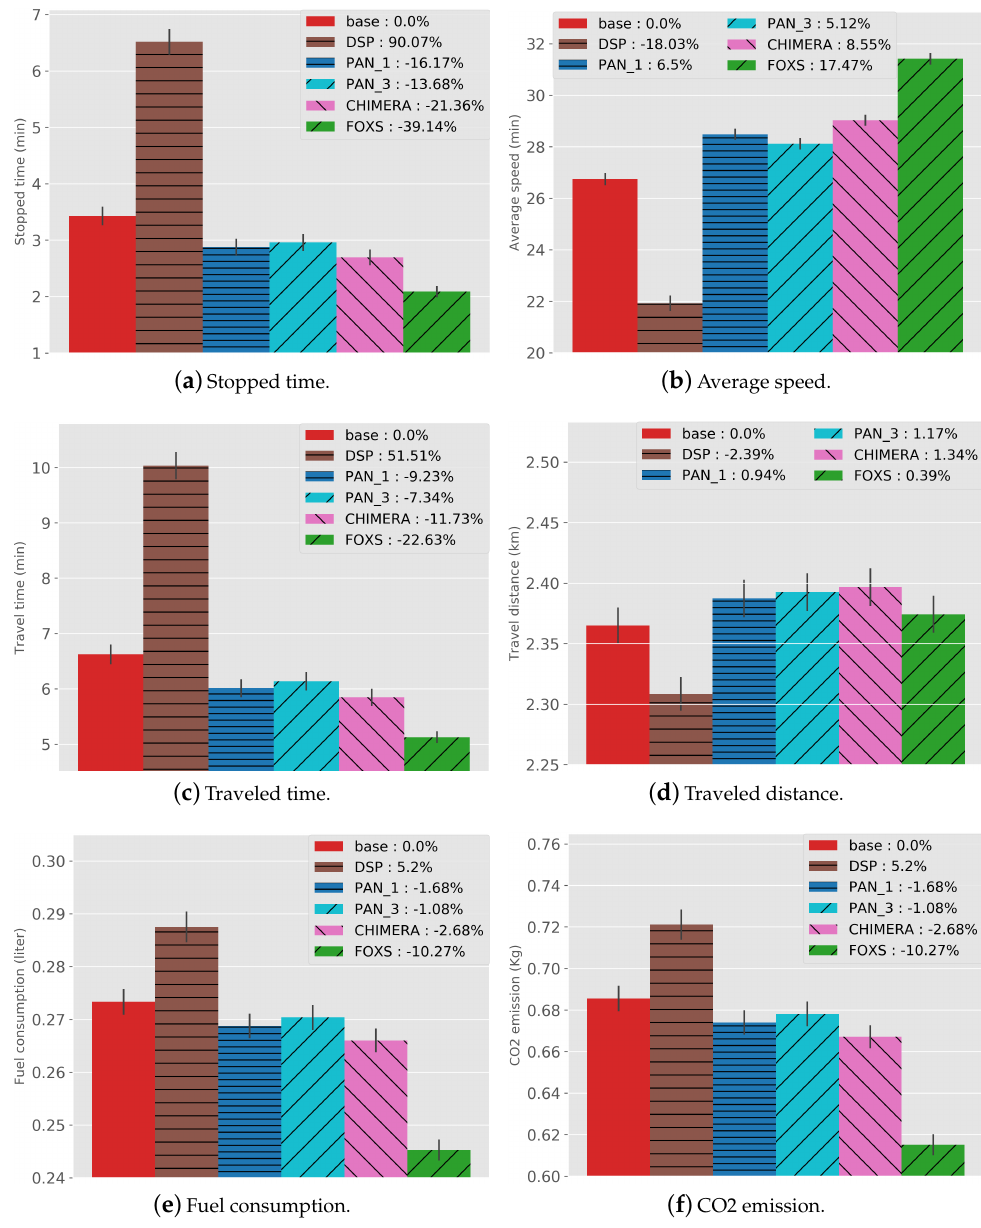
Figure 9. Traffic Efficiency Results—Ottawa Scenario.